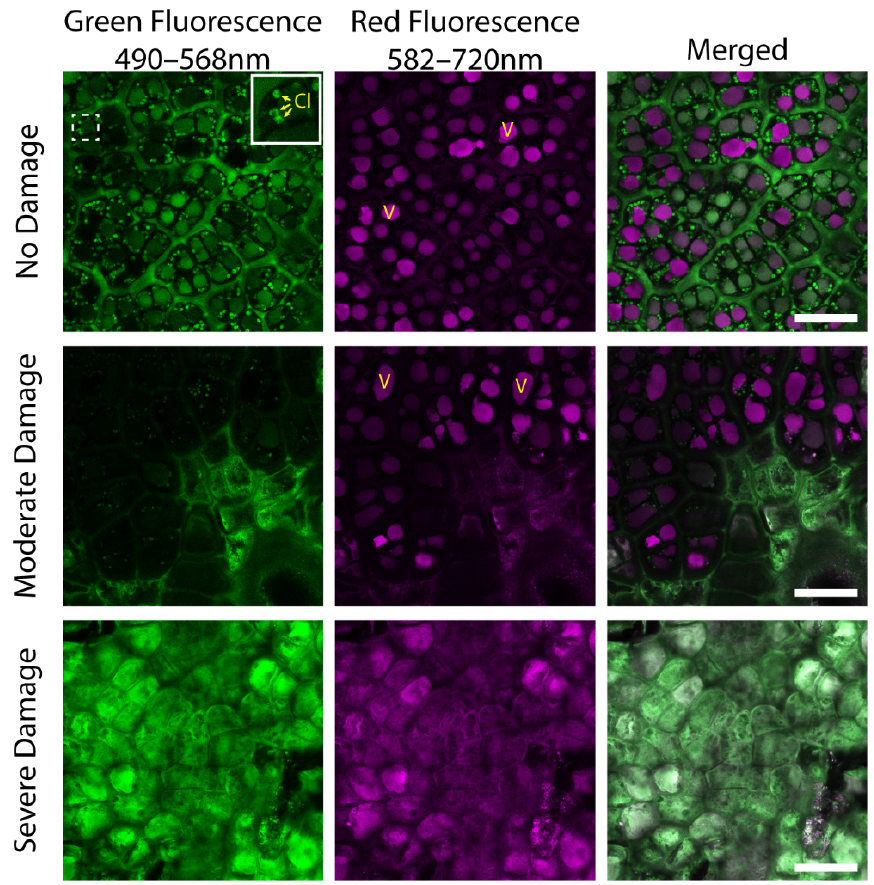
Figure 2. Sunburn damage results in decreased chlorophyll and anthocyanin autofluorescence and the eventual death of epidermal cells which become filled with an autofluorescent stress-related compound. Confocal micrographs of tangential sections of ‘Ambrosia’ apple epidermis exhibit no, moderate, and severe sunburn damage. V, vacuole; Cl, chloroplasts. Scale bars = 50 µm.